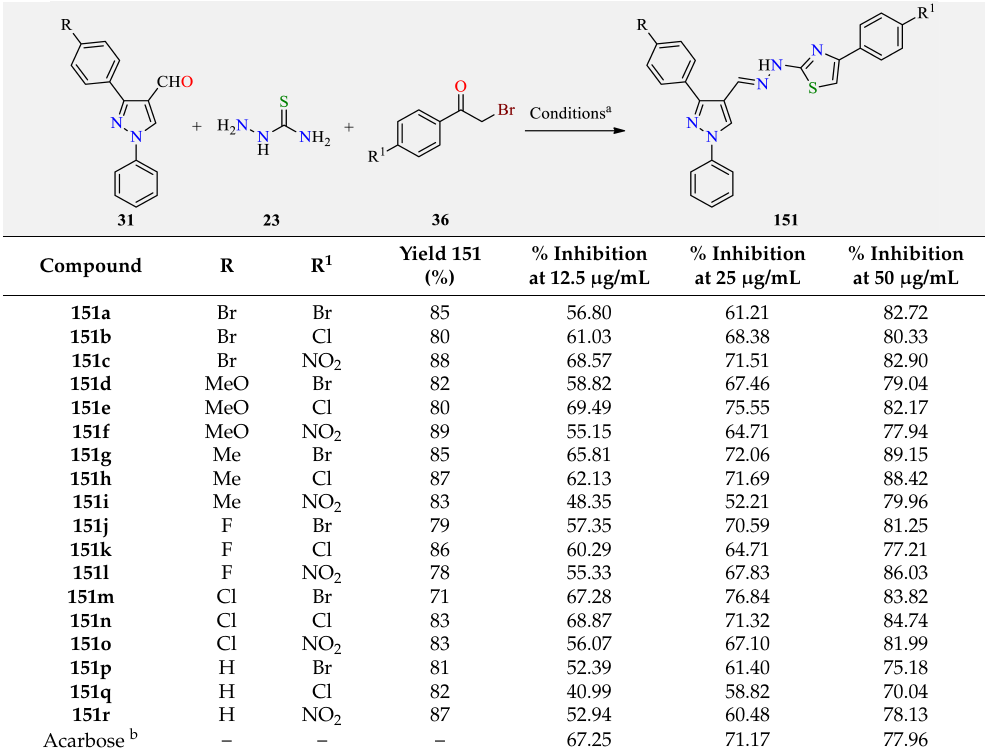
a Reaction conditions: 1-aryl-3-phenyl-1 H -pyrazole-4-carbaldehydes 31 (1 mmol), thiosemicarbazide 23 (1.1 mmol), and substituted α -bromoacetophenones 36 (1 mmol), EtOH (10 mL), reflux, 5 min. b Reference compound.